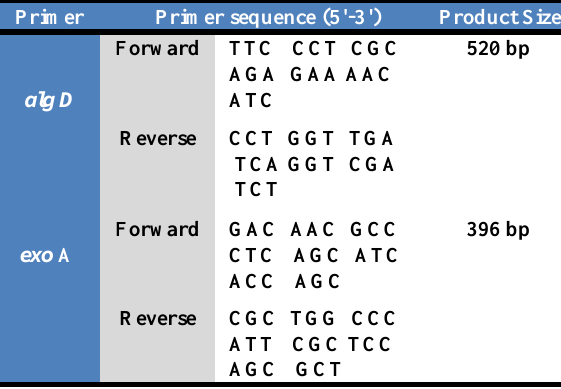
Table, 1: Biological materials for DNA primers.